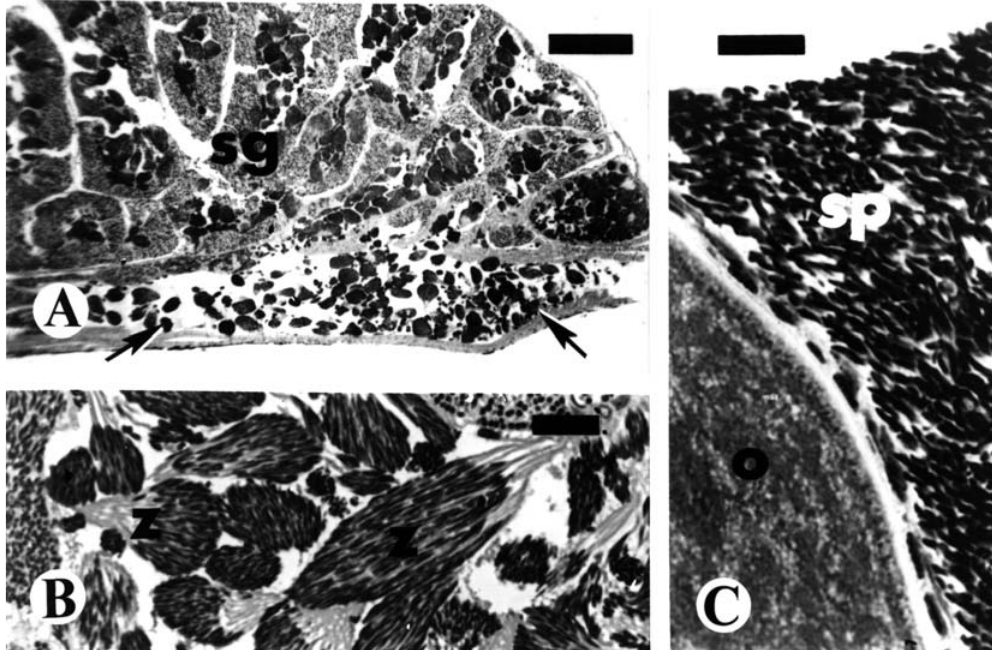
Fig. 15. Light micrographs through gonads of Bryconadenos tanaothoros . A, mid-sagittal section through testis of mature male, SL 36.6 mm (USNM 352061); sg, spermatogonial region; arrows, spermatozeugmata within storage region of testis; bar, 200 µ m. B, testis storage region of same specimen showing well-organized spermatozeugmata (z); bar, 20 µ m. C, section through ovary of mature female, SL 34.4 mm (USNM 352061), showing spermatozoa (sp) within ovarian lumen; o, oocyte cytoplasm; bar, 10 µ